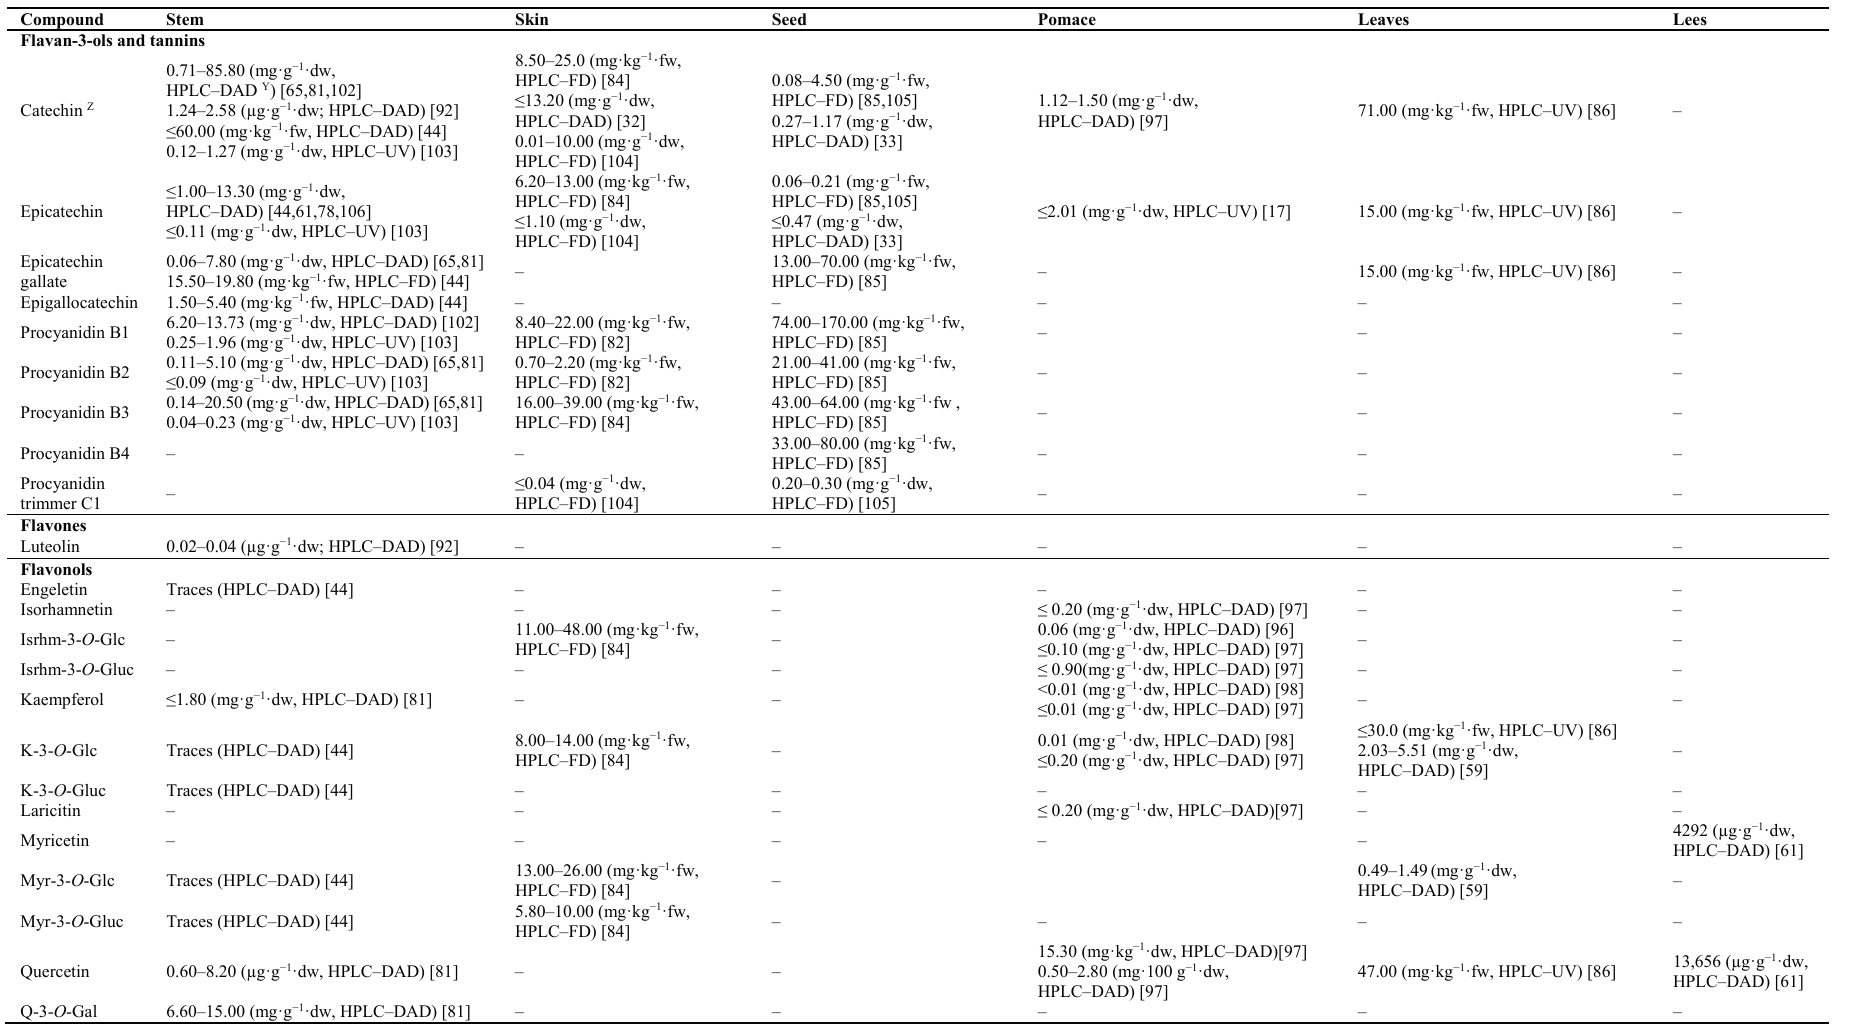
Table 3. Content in flavan-3-ols and tannins, flavones, and flavonols in winery residues of red varieties of Vitis vinifera